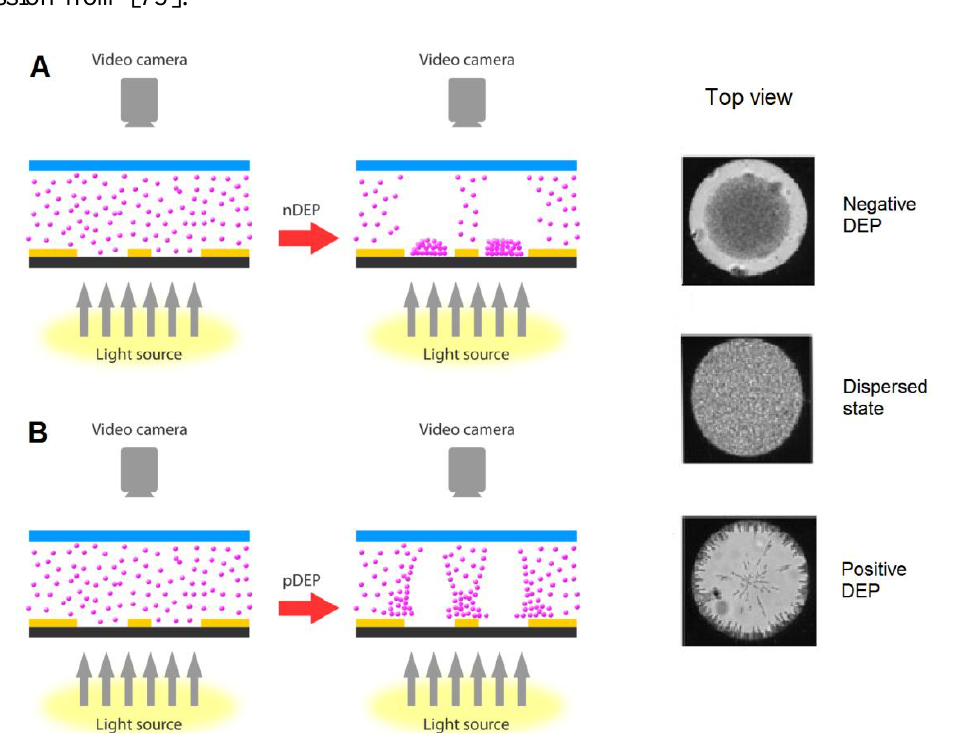
Figure 2. A schematic diagram of the movement of particles within the dot microelectrode device when experiencing ( A ) negative DEP, ( B ) positive DEP. Reproduced